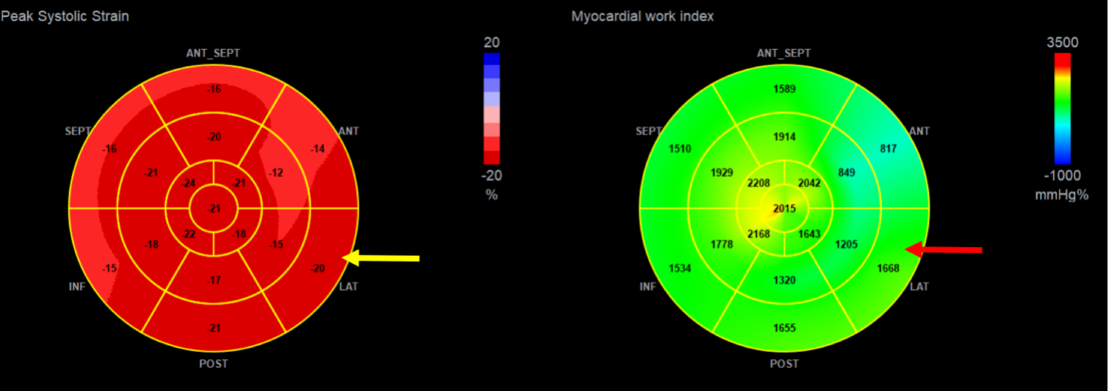
Figure 8. The example of the “Bull’s-eye” representation (obtained from long-axis, 2- and 4-chamber apical views) of regional strains in the MAD − patient. Arrows present basal lateral segment with normal (not augmented) values of longitudinal strain (yellow arrow) and myocardial work index (red